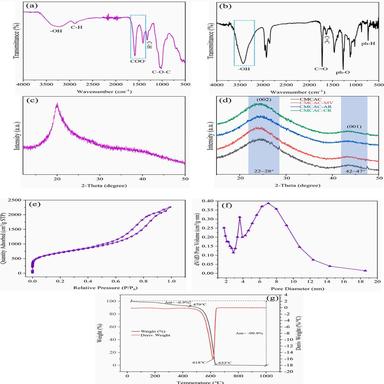
FTIR spectra of (a) CMC and (b) CMCAC; XRD patterns of (c) CMC and (d) CMCAC before and after dye adsorption; (e) N2 adsorption/desorption isotherms and (f) pore-size distribution of CMCAC; (g) TGA and DTG curves of CMCAC.